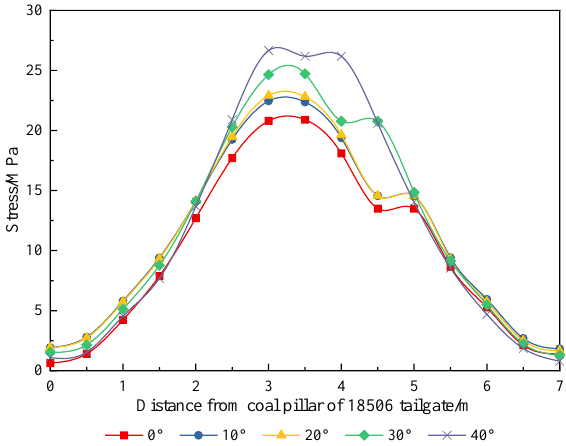
Figure 14. Vertical stress curve of surrounding rock with different top cutting angles.